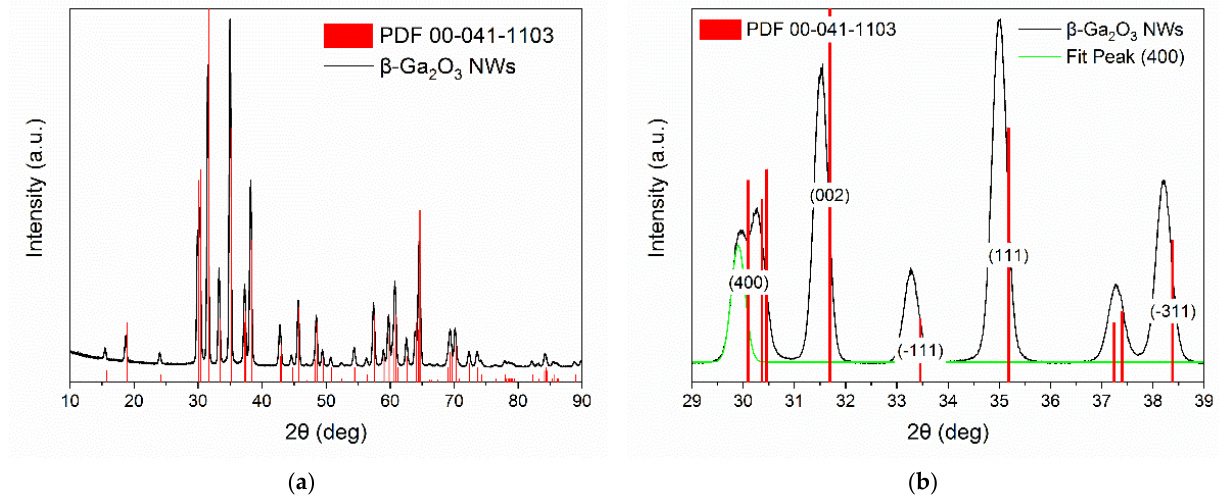
Figure 9. ( a ) X-ray diffractogram of β -Ga 2 O 3 nanowires; ( b ) The most prominent peaks of the diffractogram in ( a ). All peaks in the diffractogram are shifted by, approximately, less than − 0.20°.